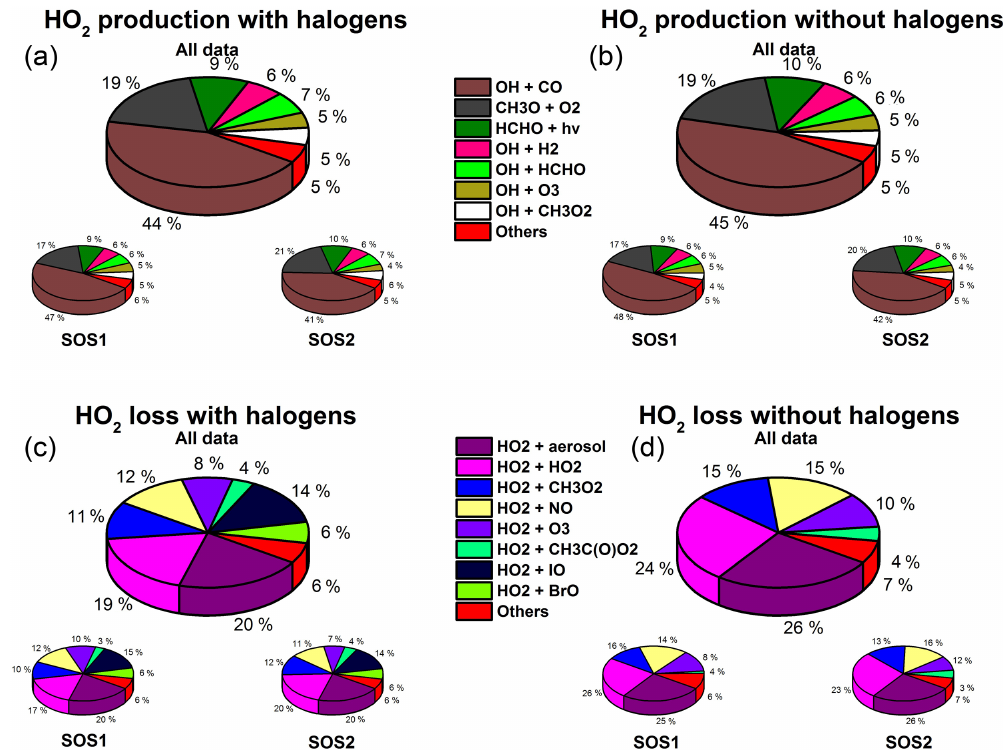
Figure 6. Processes controlling the (a) instantaneous HO 2 radical production around noon (11:00–13:00LT) for box model simulations with halogen chemistry; (b) the instantaneous HO 2 radical production around noon for box model simulations without halogen chemistry; (c) the instantaneous HO 2 radical loss around noon for box model simulations with halogen chemistry; (d) the instantaneous HO 2 radical loss around noon for box model simulations without halogen chemistry. The main charts show the average results for SOS1 + SOS2, with results for SOS1 and SOS2 shown separately in the smaller charts.